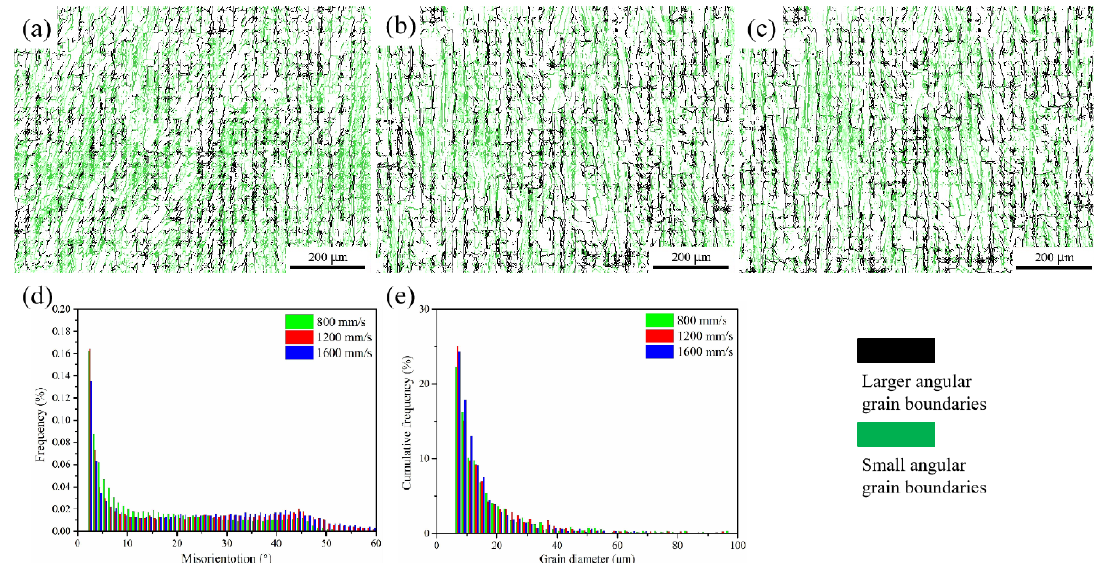
Figure 7. Grain boundary distribution of K418 alloy at different scanning speeds (( a ) 800 mm/s; ( b ) 1200 mm/s; ( c ) 1600 mm/s), ( d ) grain boundary size statistics of K418 alloy at different scanning speeds, and ( e ) grain size statistics of K418 alloy at different scanning speeds.